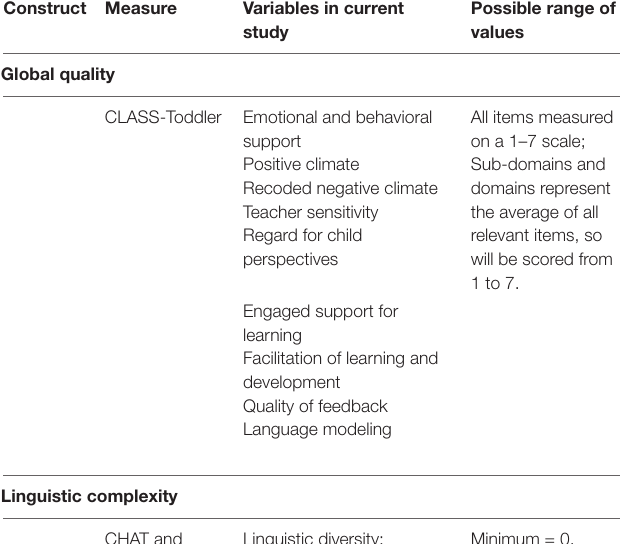
TABLE 1 | Variables in the current